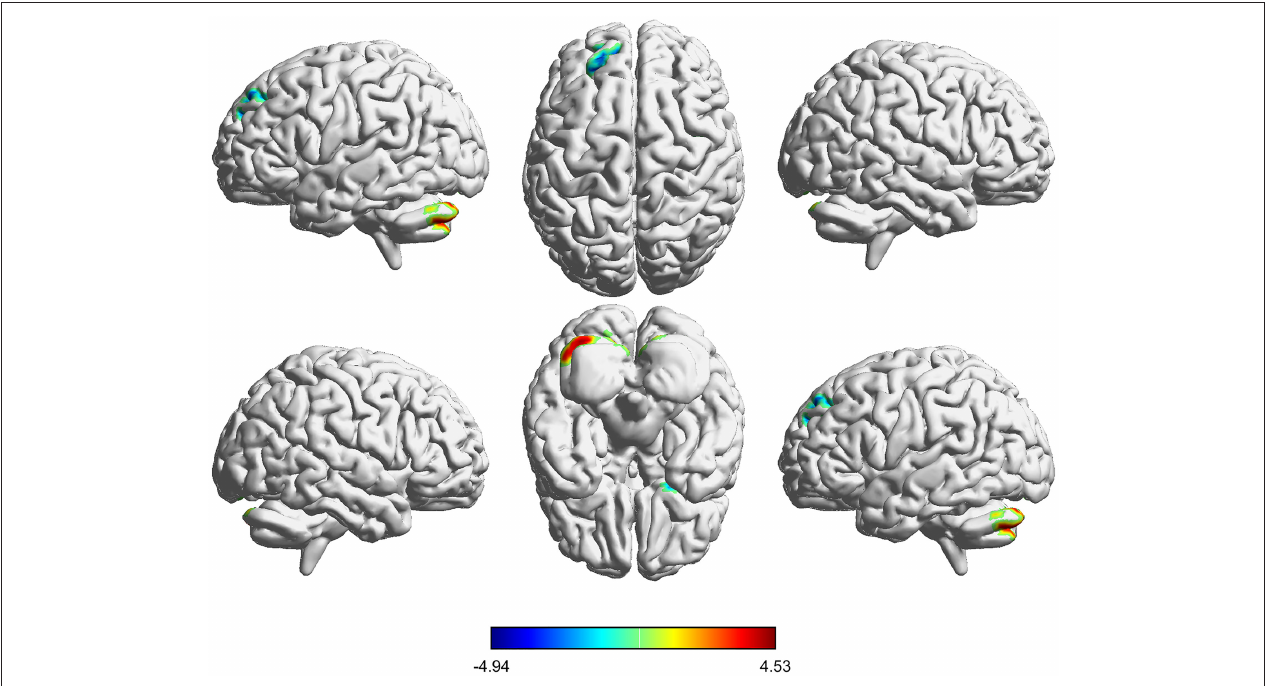
FIGURE 2 | Voxelwise comparison of DC between participants in the pre-CPAP and HC groups. Brain clusters showing a significant difference in degree centrality (DC) in the pre-CPAP OSA patients compared with those of participants in the HC group. Hot color (cool) indicates significantly increased (decreased) DC in the pre-CPAP